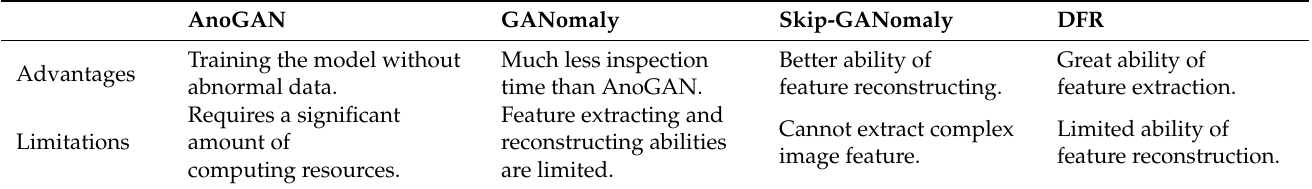
Better ability of feature reconstructing. Cannot extract complex image feature.